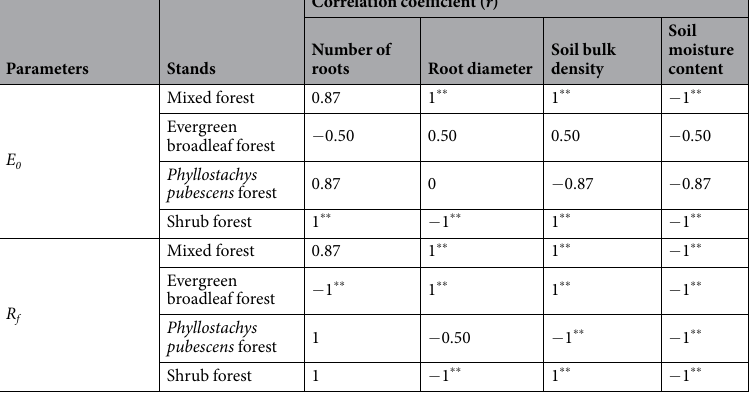
Table 2. Correlation of soil elastic-plastic properties with root properties and soil properties. Spearman correlation analysis is used in this paper. ** Represents significance level < 0.01; * Represents significance level < 0.05.